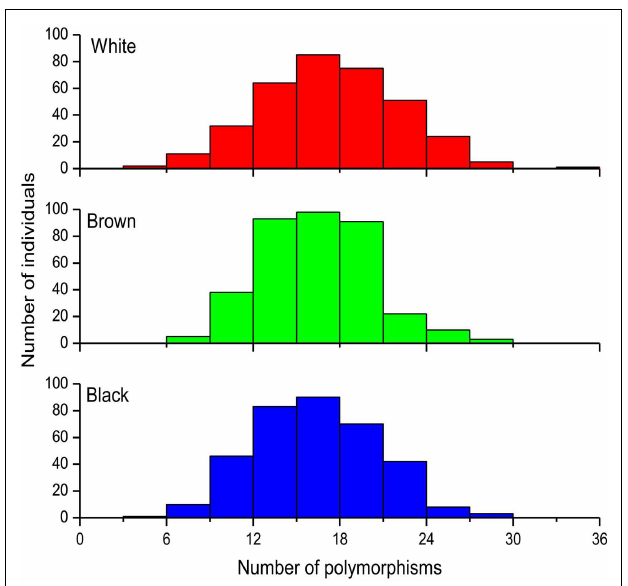
FIGURE 2 | Frequency histograms of the distribution of 44 PGx polymorphisms among self-identified (White n = 342), Brown ( n = 352), and Black Brazilians ( n = 342). The data represent the total number of minor alleles at the 44 loci, in each individual.